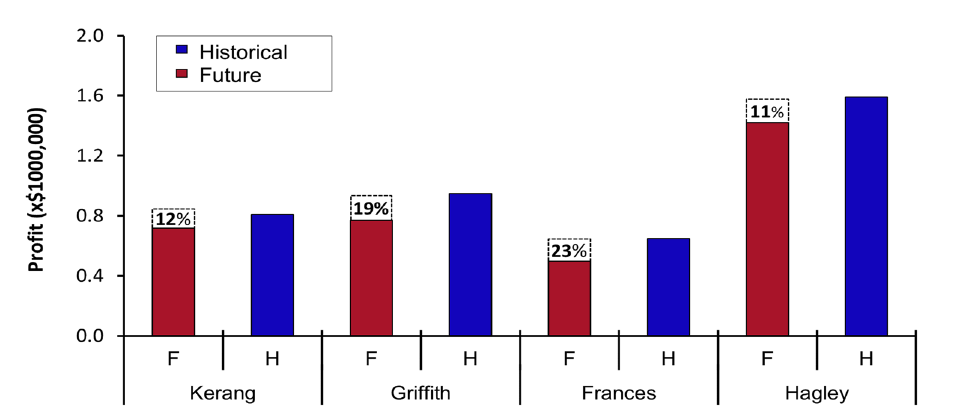
Figure 8. Average whole farm profitability across a rainfall gradient for four representative environments in Australian irrigated cropping regions under historical (H = blue bars) and future (F = red bars) climates. Dotted bar segments represent percentage reduction in average whole farm